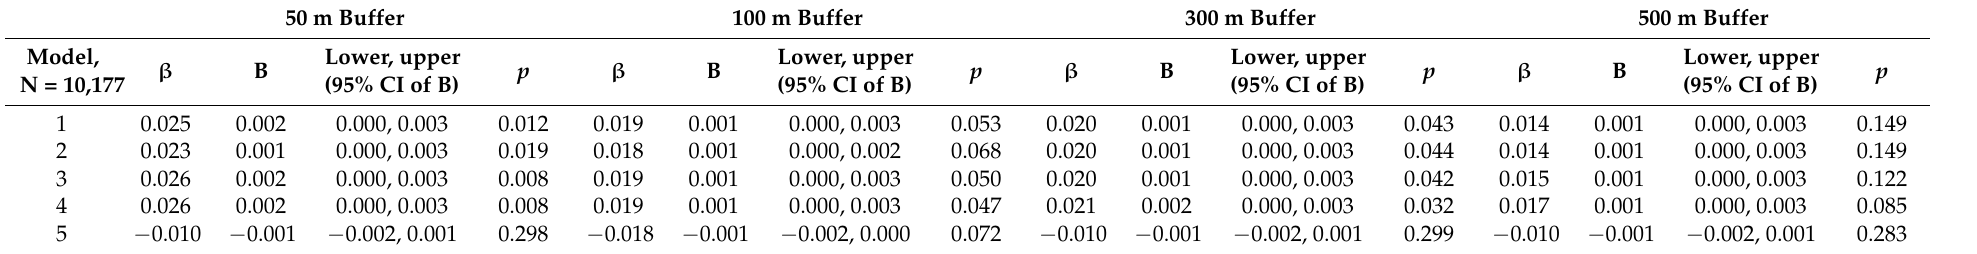
Table 8. Associations between residential greenspace at 50 m, 100 m, 300 m, and 500 m buffers, and life satisfaction (subsample: working). 50 m Buffer